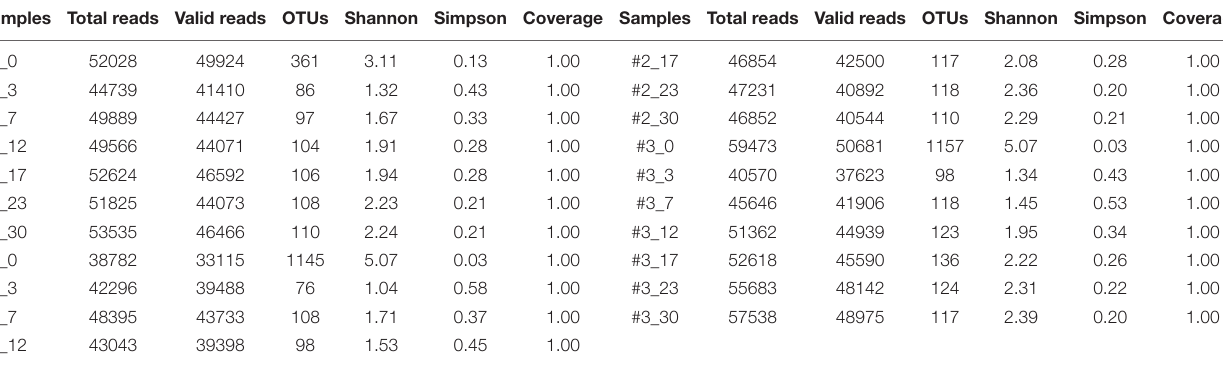
FIGURE 1 | Changes in pH and Titratable acidity (TA) (A) and nitrite concentration (B) during traditional northeast sauerkraut fermentation from different households. #1, #2, and #3 represented three different households. TABLE 1 | Sequence numbers and alpha diversity index values during traditional northeast sauerkraut fermentation from different